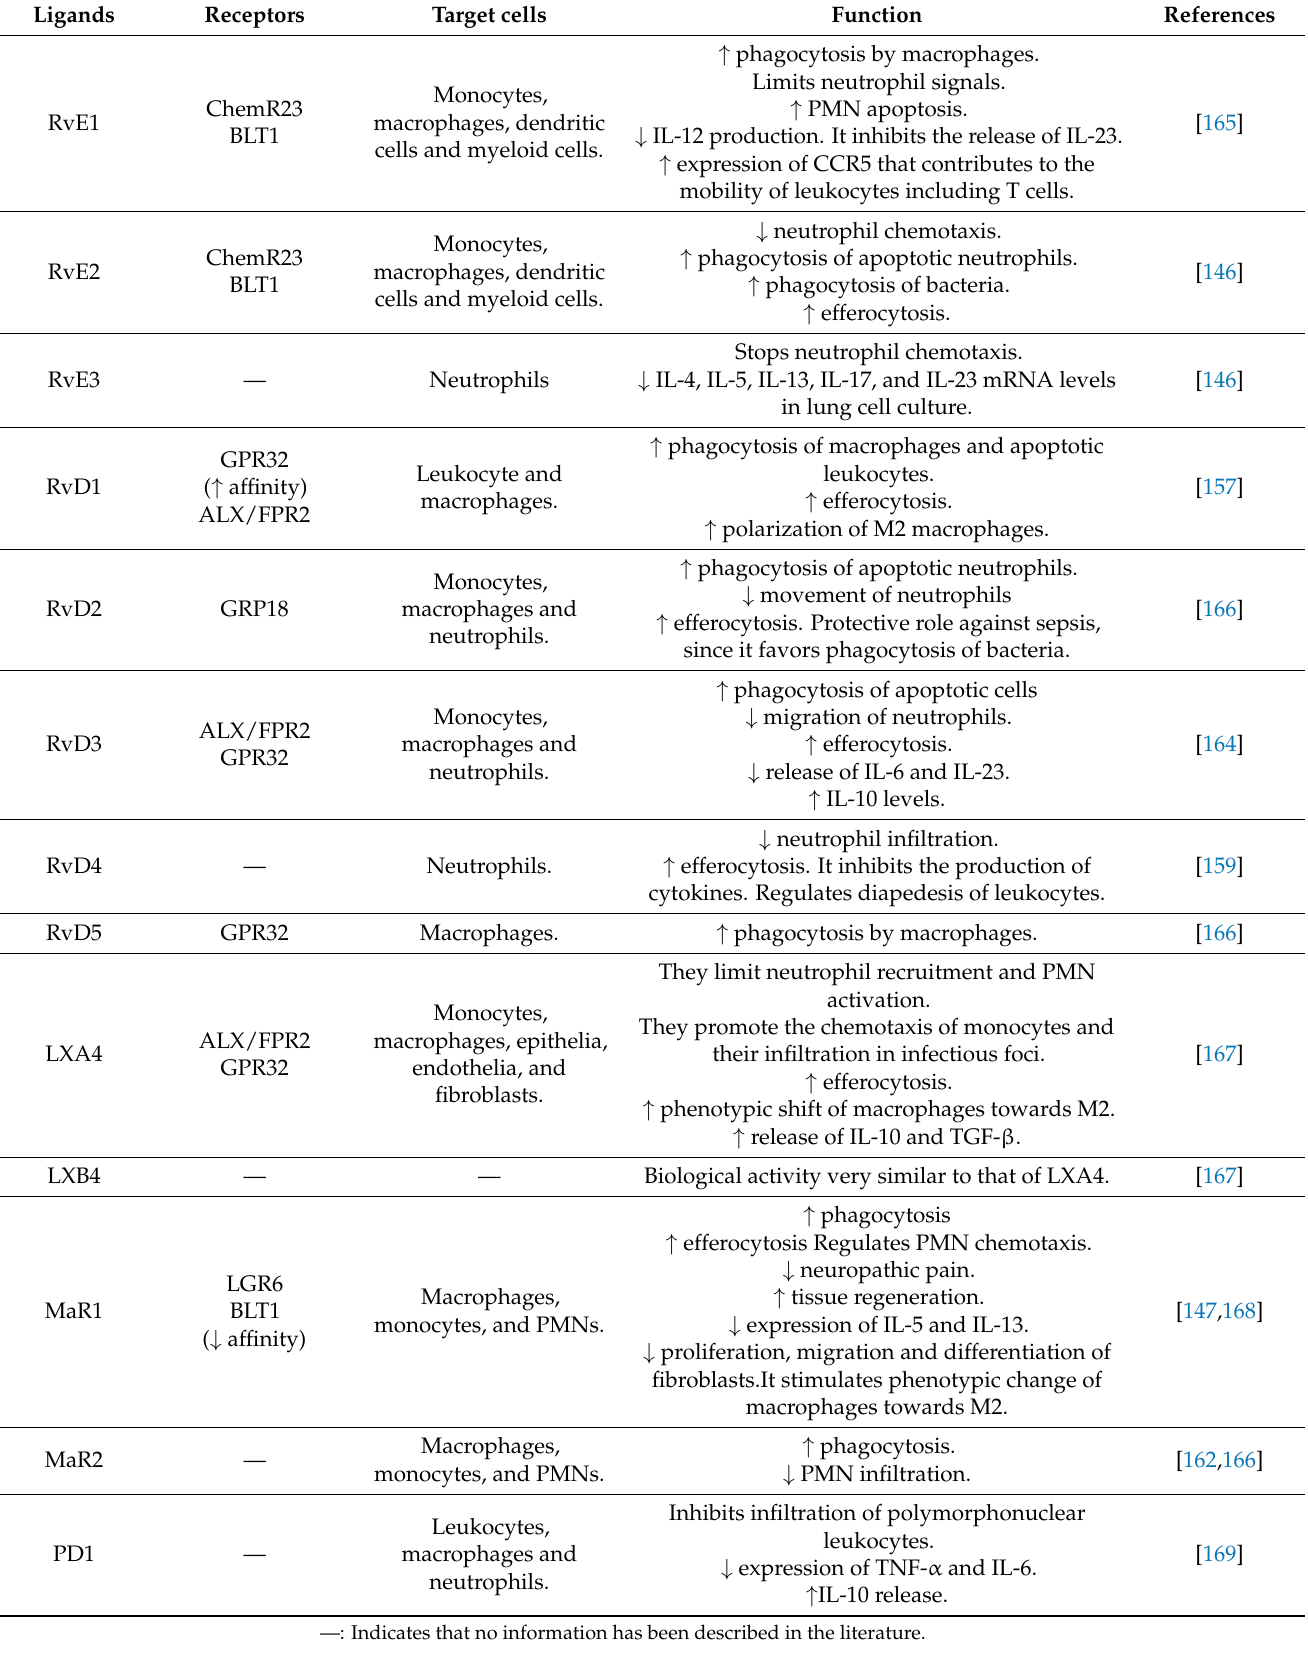
Table 2. Receptors, target cells, and biological function of